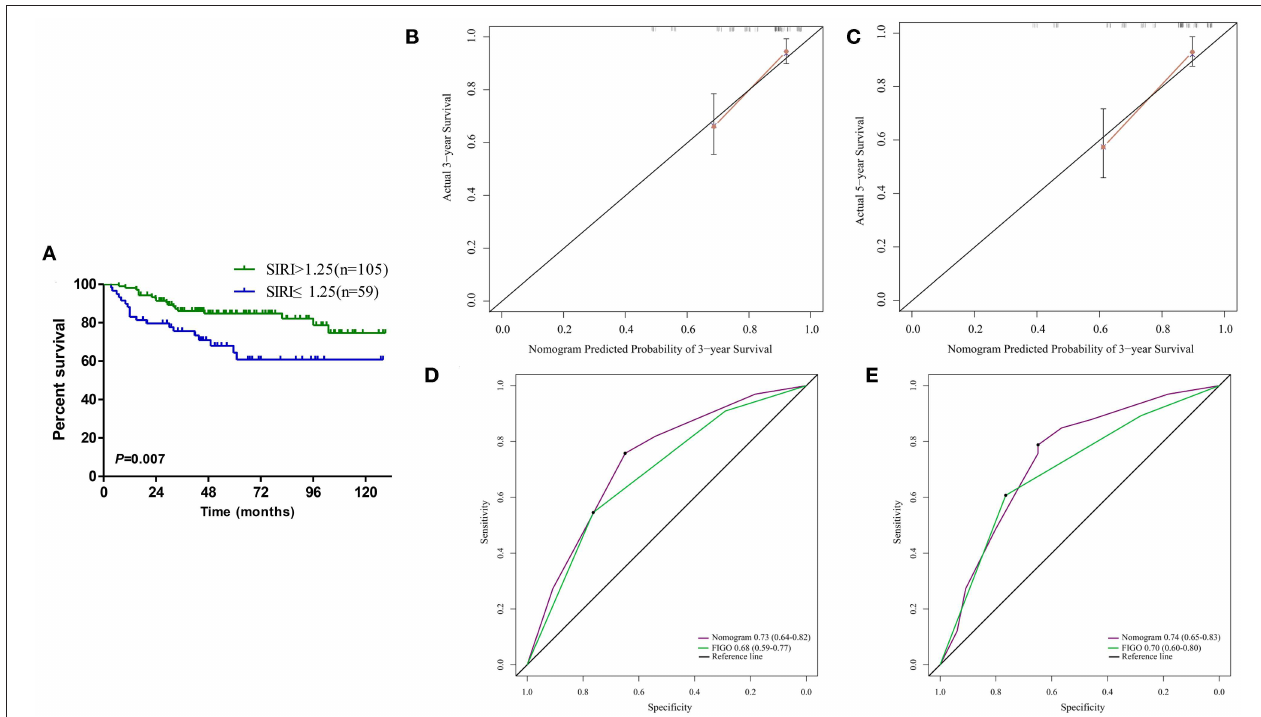
FIGURE 5 | (A) Kaplan–Meier survival curves for patients stratified based on SIRI in validation cohort. (B) The 3-years survival rate of cervical cancer patients predicted by nomogram is highly consistent with the actual observed values in validation cohort. (C) The 5-years survival rate of cervical cancer patients predicted by nomogram is highly consistent with the actual observed values in validation cohort. (D) The ability of ROC analysis nomogram to predict the 3-years survival rate of the cervical cancer patients, the nomogram has a larger AUC than FIGO staging in validation cohort. (E) The ability of ROC analysis nomogram to predict the 5-years survival rate of the cervical cancer patients, the nomogram has a larger AUC than FIGO staging in validation